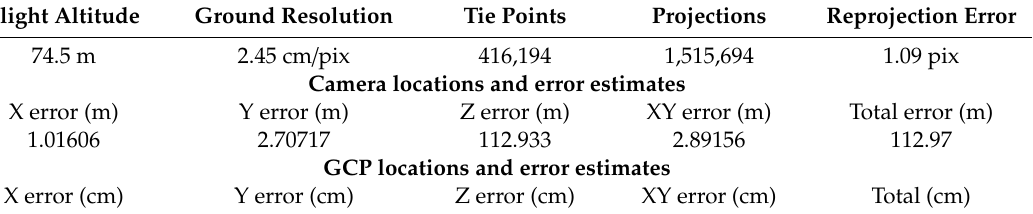
Table 1. Accuracy data of the developed reference model.